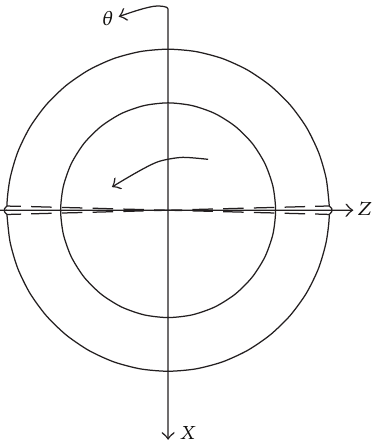
Figure 2: Hz-Hz configuration of two-groove oil journal bearing.